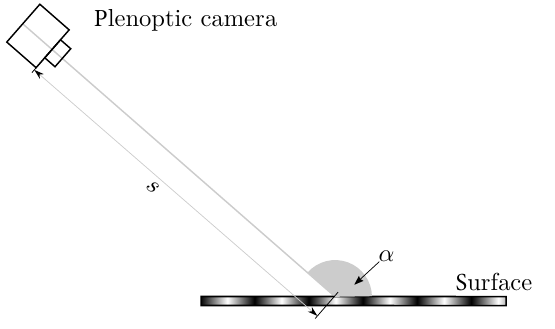
Figure 10. Plenoptic measurement setup. Expected measurement uncertainty can be predicted based on the given geometric setup, the surface pattern and the MTF of the plenoptic